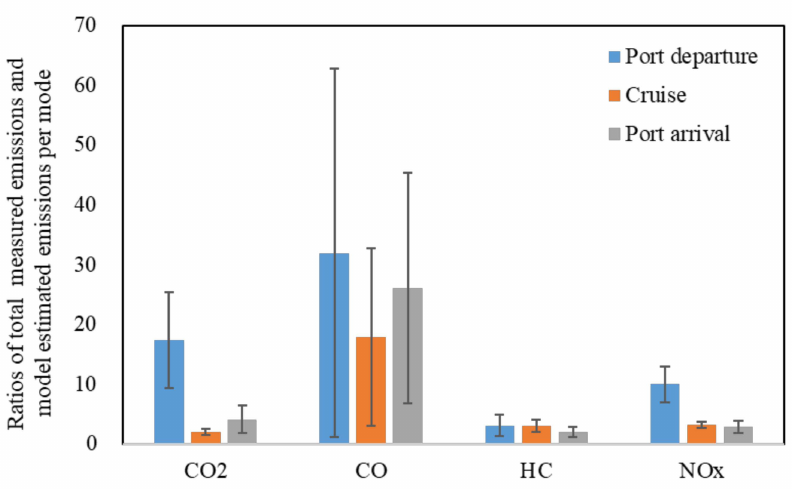
Figure 4. Ratios of the total measured emissions to estimated emission from the AIS model in each mode. Error bars show the 95% confidence intervals of the mean